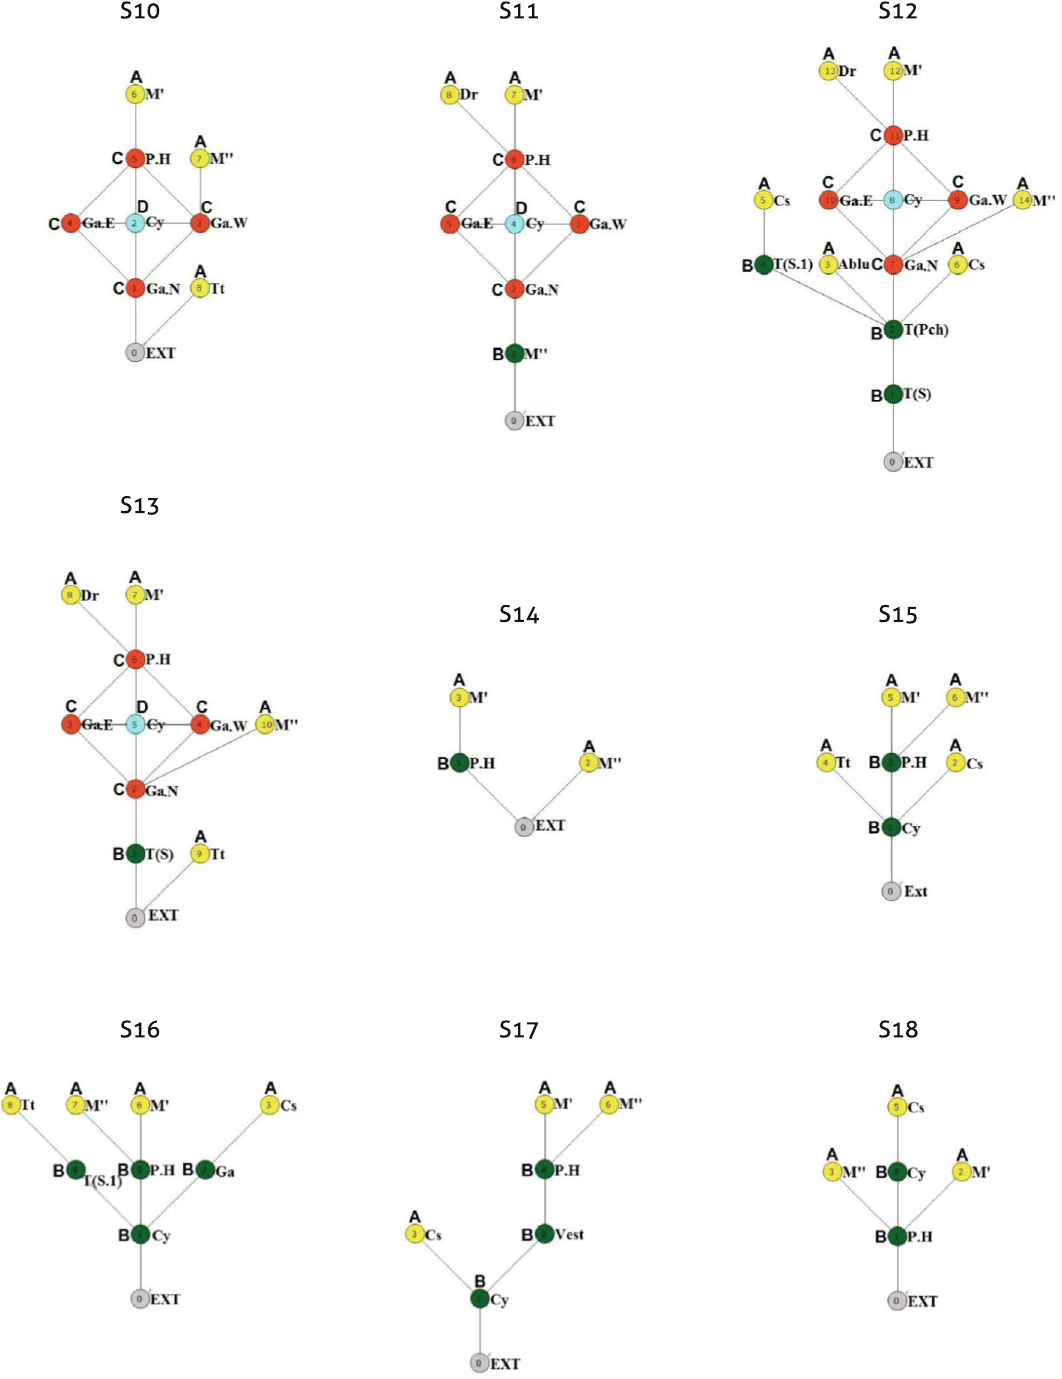
Fig. 6 Justified graphs with labelling of spaces and visual characterisation: S10–S18 (Source: the